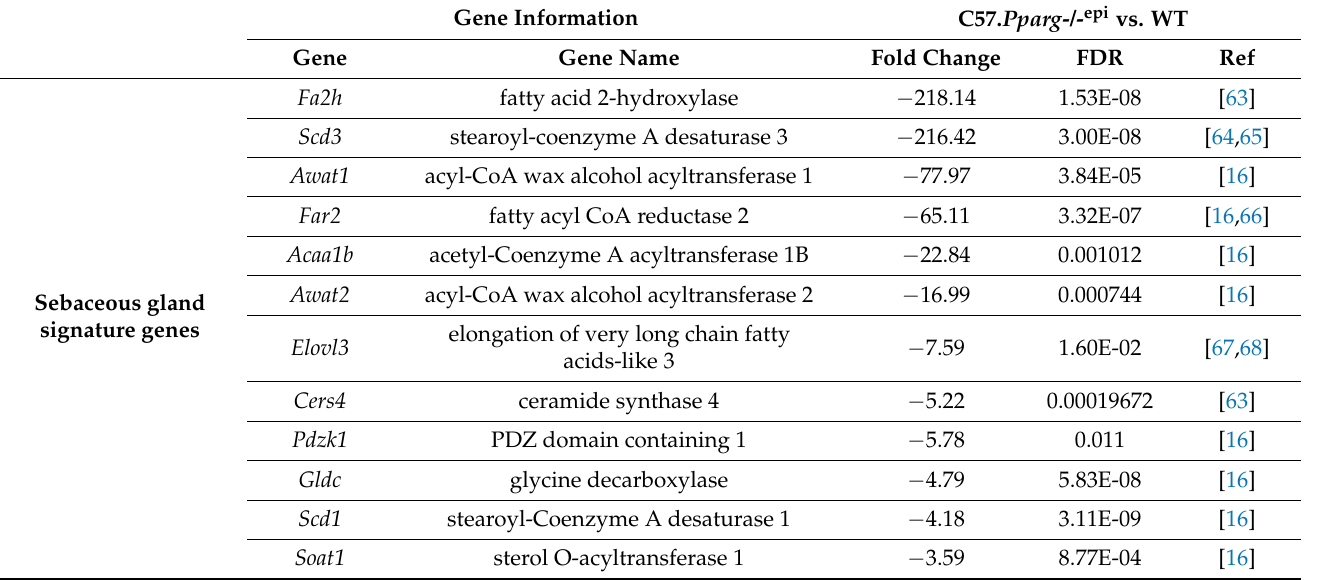
Table 2. Differentially expressed transcripts that represent sebaceous gland signature genes required for sebum production and genes required for fatty acid metabolism that are suppressed in C57. Pparg -/- epi mice. Gene Information C57. Pparg -/- epi vs.